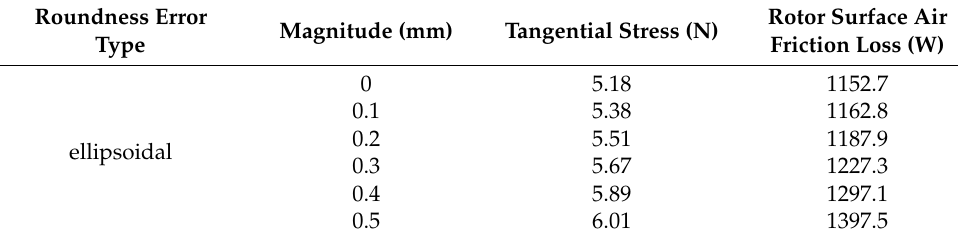
Table 4. The air friction loss on the outer surface of the rotor corresponding to the elliptical roundness error at different magnitudes.